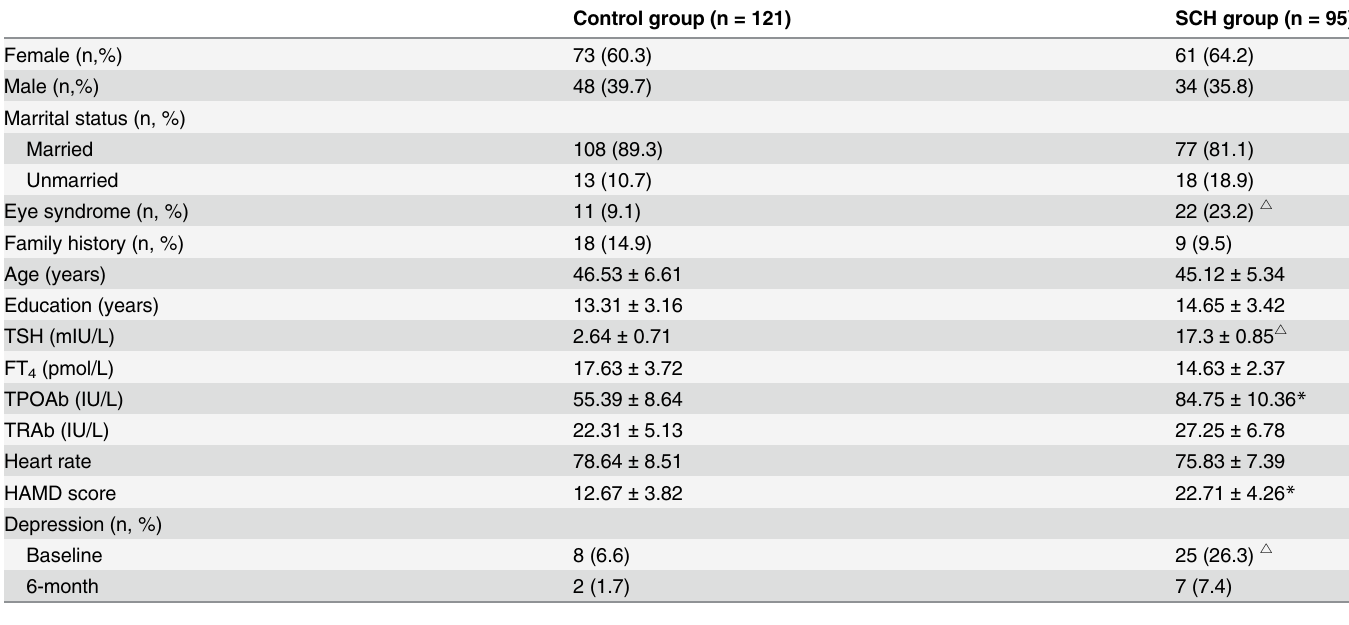
Table 1. Clinical demographics of Graves ’ disease